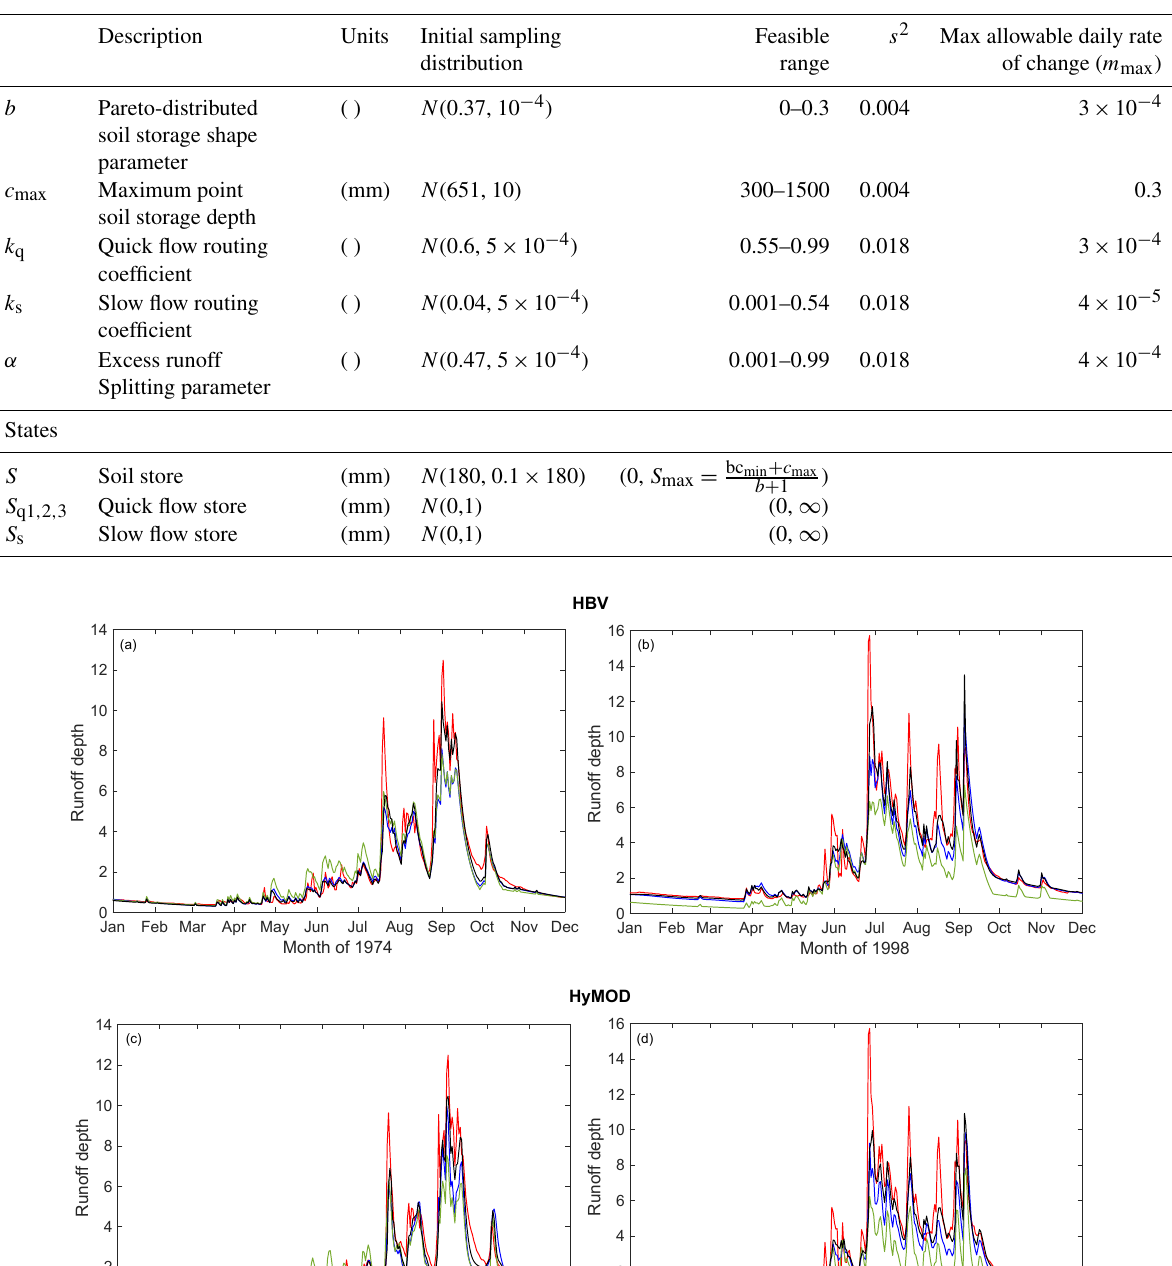
Table 5. LL EnKF inputs for the HYMOD model case.